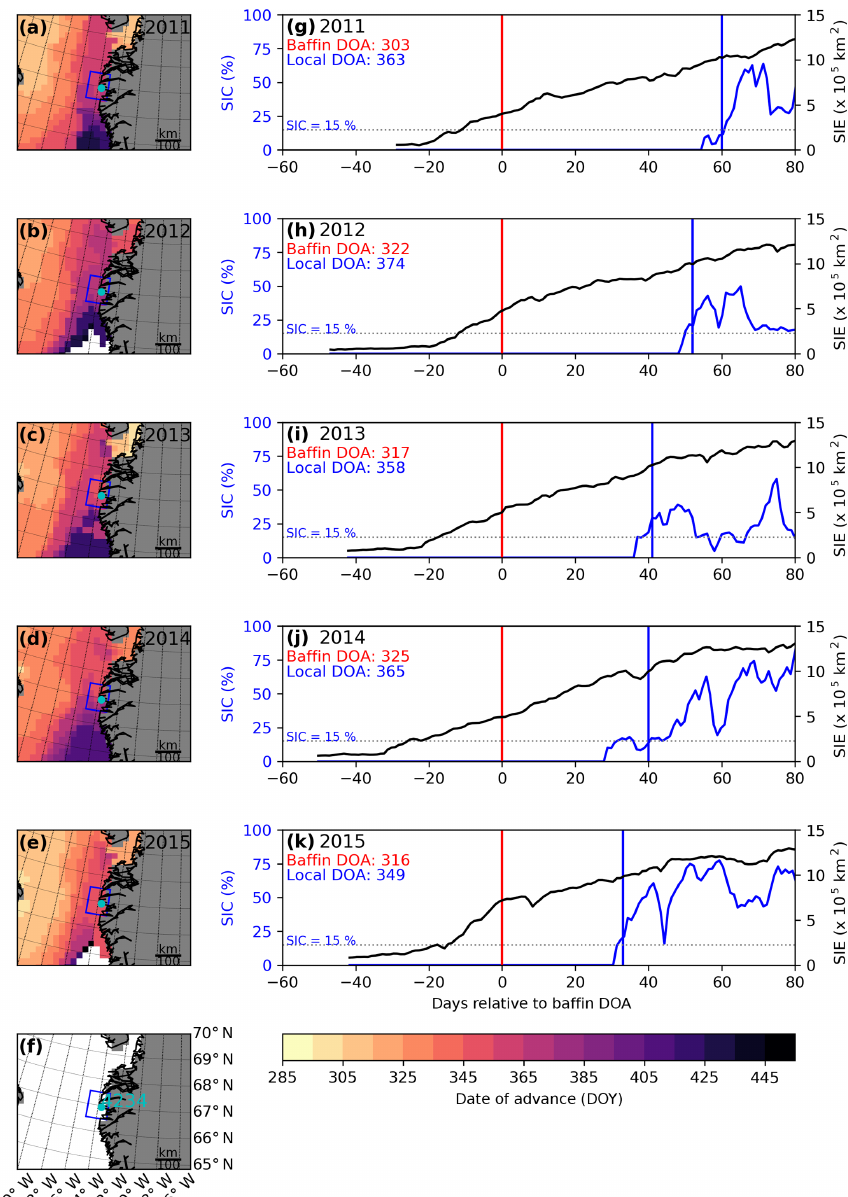
Figure 3. Maps of the Baffin Bay date of sea ice advance (DOA) for (a–e) 2011–2015. The location of Sisimiut (WMO code 4234) is marked in cyan, white indicates locations where DOA was not observed, and gray indicates land. Panel (f) shows reference grid coordinates for maps (a–e) . DOY after 365 (or 366 in 2012) indicates that DOA occurs after 1 January the following year. Time series of sea ice extent (SIE) for the Baffin Bay region (black) and mean sea ice concentration (SIC) for the local domain (blue), 66.5 to 67.5 ◦ N and 53 to 55 ◦ W (blue polygon shown in a–f ), relative to the Baffin-wide DOA (vertical red line) for (g–k) 2011–2015. The vertical blue line shows the mean DOA for the local domain. The horizontal dotted line represents the 15% SIC threshold used to identify the